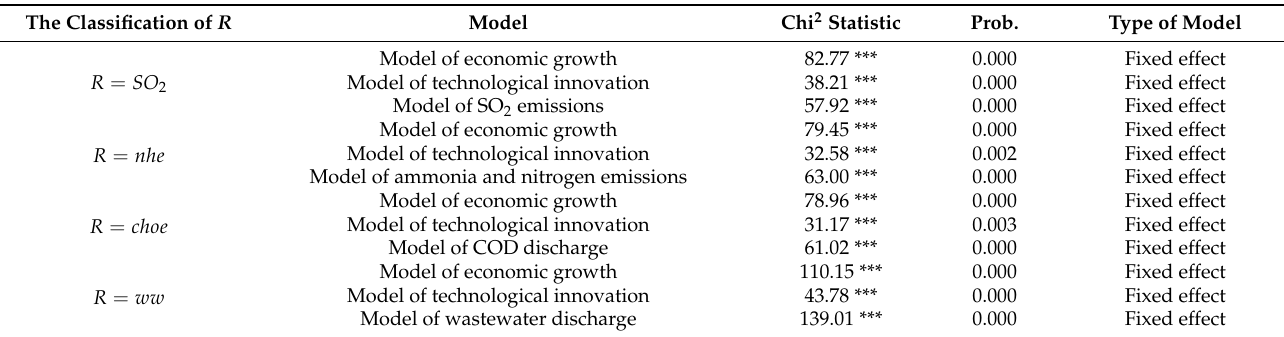
Table 3. Results of the Hausman